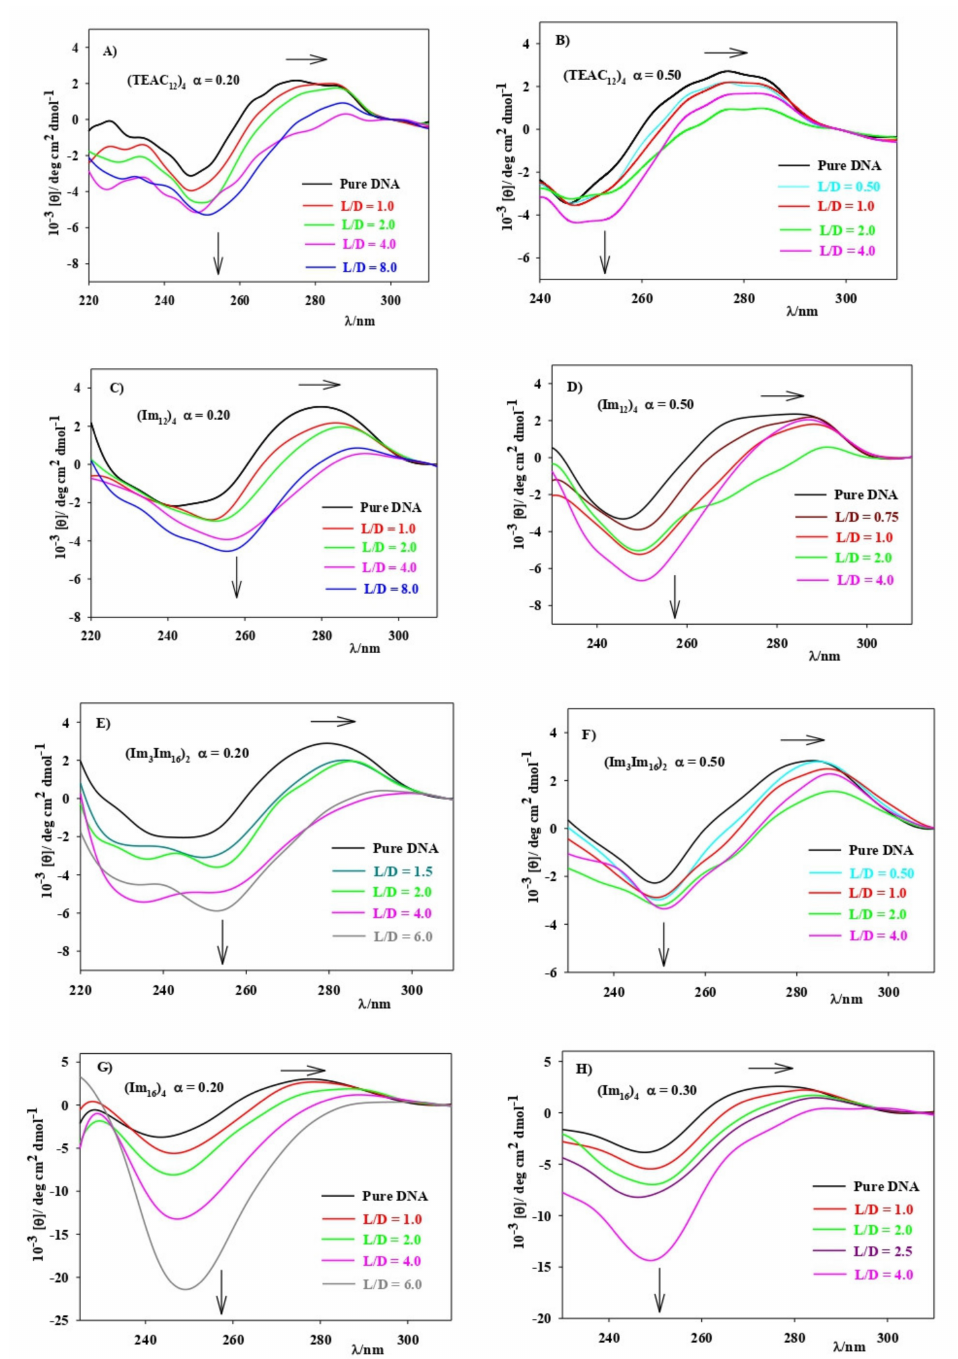
Figure 5. Dependence of the circular dichroism spectra of the CAL/DOPE/DNA lipoplexes on L/D for different molar ratios α . T = 303 ± 0.1 K.; ( A ) α = 0.20 for (TEAC 12 ) 4 ; ( B ) α = 0.50 for (TEAC 12 ) 4 ; ( C ) α = 0.20 for (Im 12 ) 4 ; ( D ) α = 0.50 for (Im 12 ) 4 ; ( E ) α = 0.20 for (Im 3 Im 16 ) 2 ; ( F ) α = 0.50 for (Im 3 Im 16 ) 2 ; ( G ) α = 0.20 for (Im 16 ) 4 ; and ( H ) α = 0.30 for (Im 16 ) 4